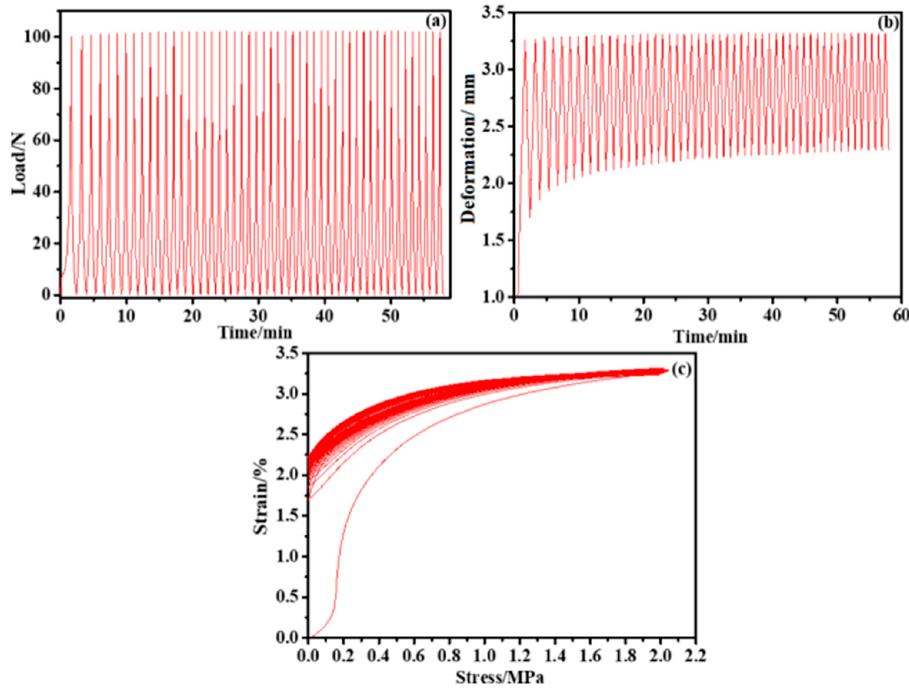
Figure 5. ( a ) Cyclic force curve applied by the press, ( b ) cyclic compression deformation curve of the sample, and ( c ) the stress–strain curve of the